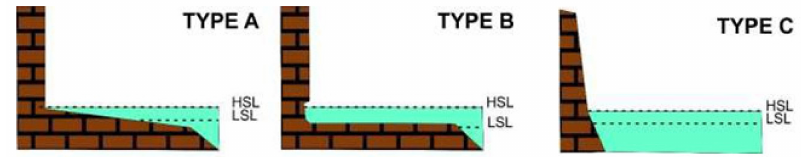
Figure 1. Classification of cliffs (modified from Sunamura, 1983;